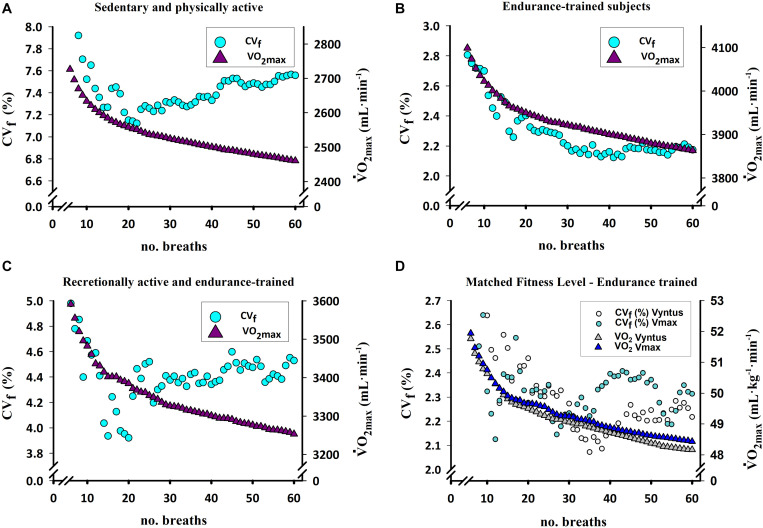
Change in the V.O2max value and its reproducibility in subjects divergent for fitness status using two different automated metabolic carts operated in breath-by-breath mode with different rolling breath-averages. (A)
V.O2max response in a heterogeneous group of sedentary and physically active overweight and obese subjects (V.O2max range: 13–40 mL/kg/min) assessed with Vmax N29 Sensormedics (n = 51). (B)
V.O2max response in a group of endurance-trained subjects (V.O2max range: 40–60 mL/kg/min) assessed with Vyntus CPX (n = 11). (C)
V.O2max response in a group of recreationally active and endurance-trained subjects (V.O2max range: 35–60 mL/kg/min) performing one test with Vmax N29 and a duplicate test with Vyntus CPX in random order (n = 11). (D)
V.O2max response assessed with the Vmax N29 and Vyntus metabolic carts in two groups of nine subjects each of similar V.O2max (V.O2max range: 40–60 mL/kg/min) (B). CVf (%), coefficient of variation calculated as proposed by Forkman (2009). Note the clear trend for lower reproducibility and a larger decay of the V.O2max the lower the fitness of the subjects. Modified from Martin-Rincon et al. (2019) with kind permission.